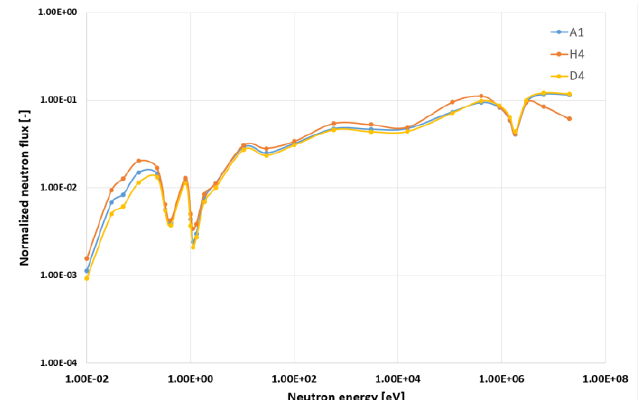
Fig. 10. Neutron spectra in A1, D4 and H4 positions